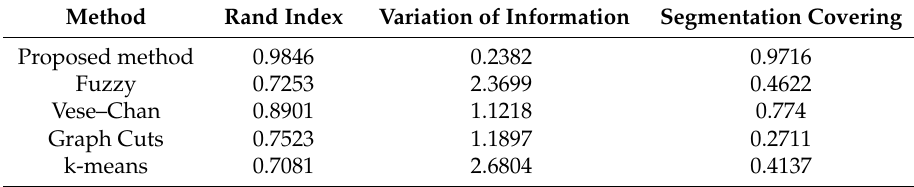
Table 2. Segmentation evaluation for several methods applied to the ‘Sectors’ image with 10 dB